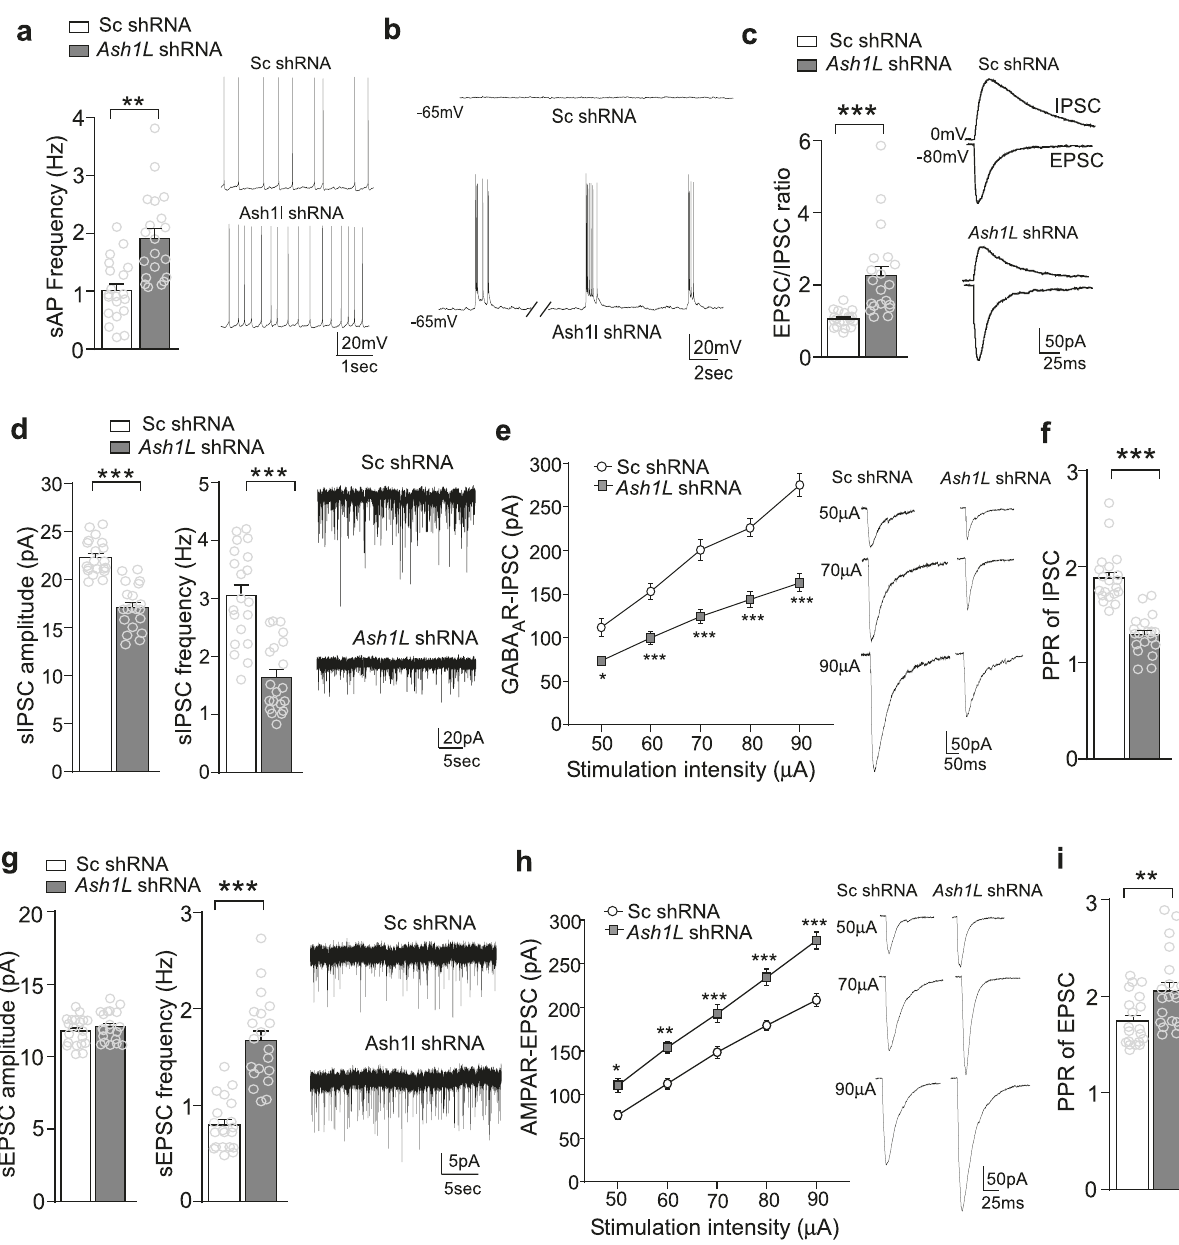
Fig. 4 Ash1L de fi ciency induces the hyperactivity of PFC pyramidal neurons and disrupts the balance of excitatory and inhibitory synaptic responses. a Bar graphs showing the frequency of synaptic-driven spontaneous action potentials (sAP) in PFC pyramidal neurons from mice infected with scrambled (sc) shRNA vs. Ash1L shRNA AAV. n = 20 cells/4 mice (2 M,2 F)/group, t 38 = 4.42, ** p < 0.01, two-tailed t-test. Inset: representative sAP traces. b Representative traces showing the membrane excitability at the hyperpolarized level ( − 65 mV) in PFC pyramidal neurons infected with sc shRNA vs. Ash1L shRNA. c Bar graphs of evoked EPSC (recorded at − 80 mV) to IPSC (recorded at 0 mV) ratio in PFC pyramidal neurons from mice infected with sc shRNA vs. Ash1L shRNA. n = 20 cells/4 mice (2 M,2F)/group, t 38 = 4.34, *** p < 0.001, two-tailed t test. Inset: representative EPSC and IPSC traces. d – f Bar graphs of spontaneous IPSC amplitude and frequency ( d ), input-output curves of evoked GABA A R-IPSC ( e ) and paired-pulse ratio (PPR) of IPSC ( f ) in PFC pyramidal neurons from mice infected with sc shRNA vs. Ash1L shRNA. n = 20 cells/4 mice (2 M,2 F)/group. d , t 38 = 7.80 (amp), t 38 = 6.19 (freq), *** p < 0.001, two-tailed t test; e , F 1,38(genotype) = 45.87, * p < 0.05, *** p < 0.001, two-way rmANOVA; f , t 38 = 7.74, *** p < 0.001, two-tailed t test. Inset: representative sIPSC and eIPSC traces. g – i Bar graphs of spontaneous EPSC amplitude and frequency ( g ), input-output curves of evoked AMPAR-EPSC ( h ) and PPR of EPSC ( i ) in PFC pyramidal neurons from mice infected with sc shRNA vs. Ash1L shRNA. n = 20 cells/4 mice (2 M,2 F)/group, g , t 38 = 7.52 test. Data are p resented as mean values ± SEM. Detailed statistical data are provided in a Source Data fi